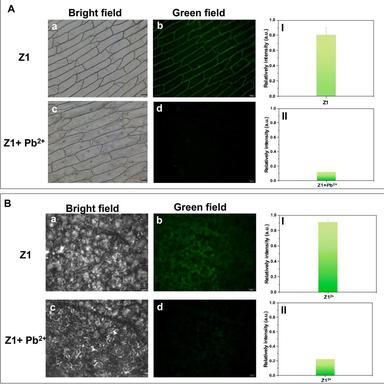
Schematic diagram of Z1 for detection of exogenous Pb2+ in living plant cell. A. Fluorescence imaging of Z1, Z1 + Pb2+ in living onion tissues. (a). Bright field image of Z1 in living onion tissues. (b). Green channel image of Z1 in living onion tissues. (c). Bright field image of Z1 + Pb2+ in living onion tissues. (d). Green channel image of Z1 + Pb2+ in living onion tissues. I. The relatively intensity of probe Z1 in onion tissues. B. Fluorescence imaging of Z1, Z1 + Pb2+ in living tobacco tissues. (a). B